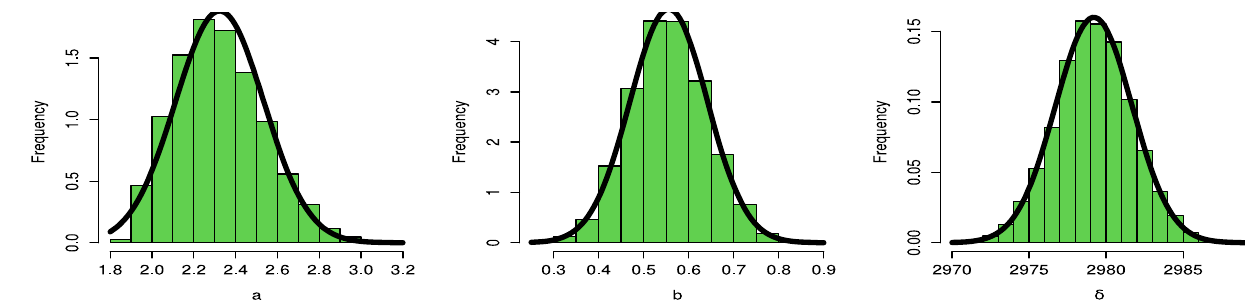
Figure 16. Histogram plots of MCMC results for Saudi Arabia data set.